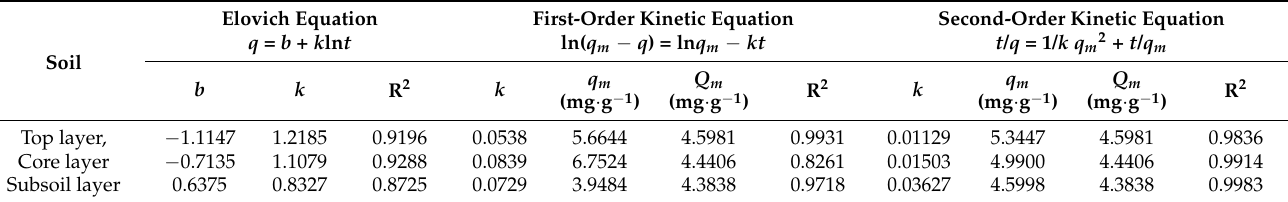
Figure 3. Adsorption kinetic characteristics of each soil. (4 mg of soil, initial concentration of Fe 3+ Table 2. Adsorption kinetic was 300 mg·L − 1 and the initial pH was 4.20, 25 °C).